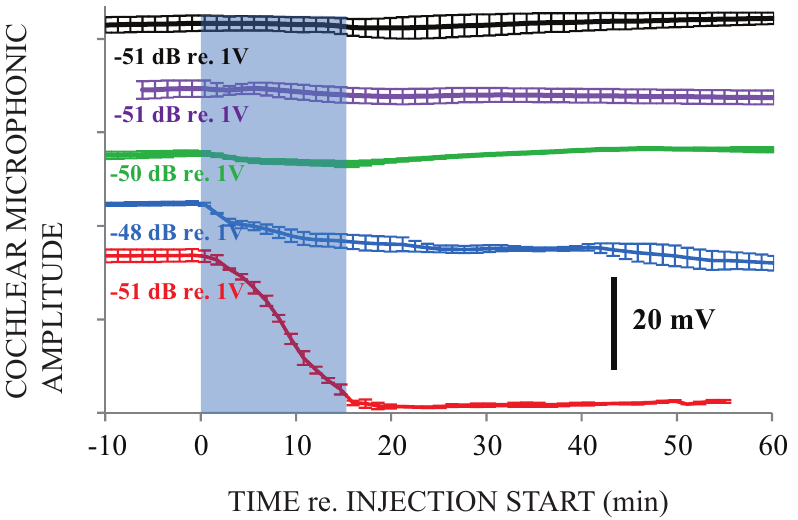
Fig 4. Cochlear microphonic (CM) measuredfrom inside the endolymphatic space of the third cochlear turn. The semi-transparent blue rectangleidentifies the 15 minute injectionduration.Values listed on the far left of the figure are averageamplitudemeasurements from the ~10 minutes of data collected before the start of injection. The ranking of measurements on the y-axis corresponds to the solution effect, with the measurements associatedwith the smallest effect at the top of the figure, progressing to the largest effect at the bottom of the figure. The noise floor for these CM measurements is approximately -85 dB, or ~35 dB down from the averageamplitudemeasurements calculatedfrom the 10 minutes of data before the injectionstart, which are those values presentedon the far left of the figure. Artificial perilymphalone (control) and 13 mM HP β CDdid not cause marked effects on CM amplitude, salicylatecaused slight and temporary effects, 27 mM HP β CD did not fully abolishthe CM but M β CDcaused total abolition.Data were obtained from three ears for each treatment